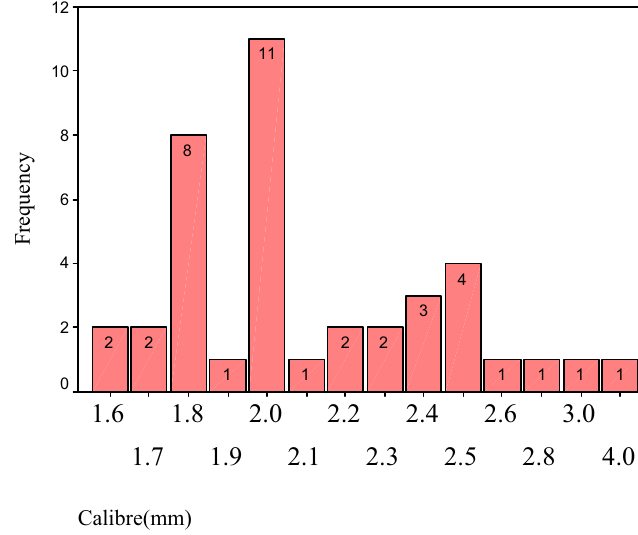
FIGURE 4 - Pedicle caliber of SIEV